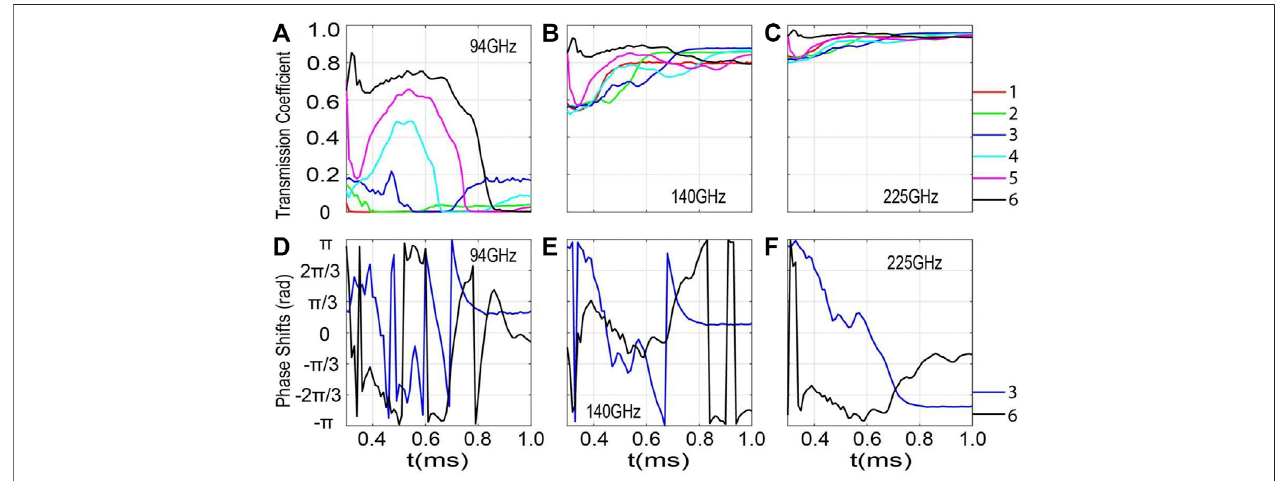
FIGURE3 | Temporal variation of transmission coef fi cient (A – C) and phase shift (D – F) of EHFsignals in the sideplasmasheath channels ofa sharp-coned reentry vehicle.Thecorrespondingcarrierfrequenciesfromlefttorightare94,140,and225 GHzrespectively.Differentchannelsarerepresentedbycurvesofdifferentcolors[as shown on the right side of (C)